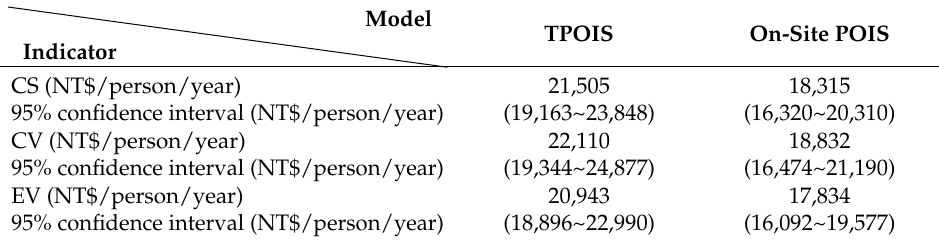
Table 8. Estimated recreation benefits of Nanwan.